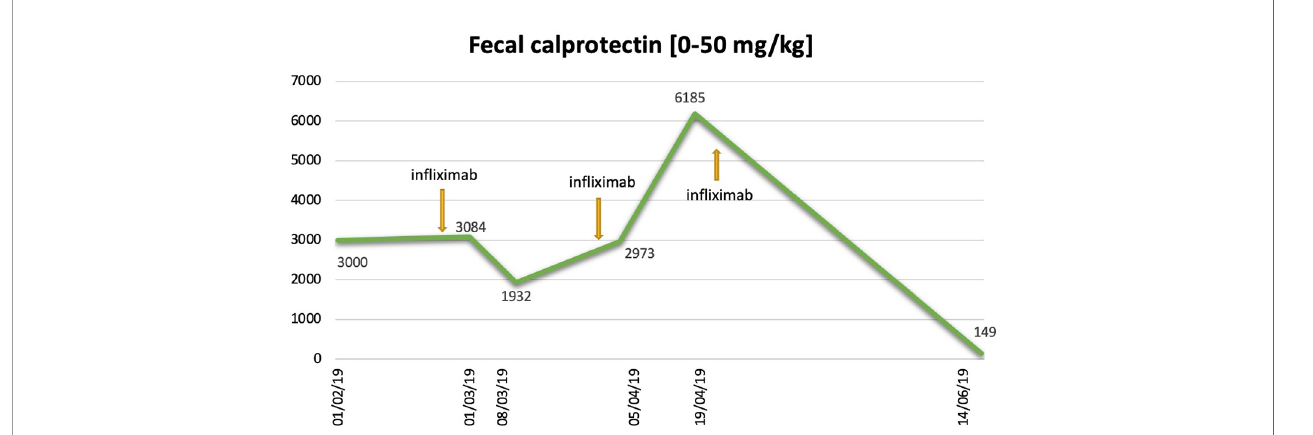
FIGURE 1 | Fecal calprotectin dosage trend and in fl iximab